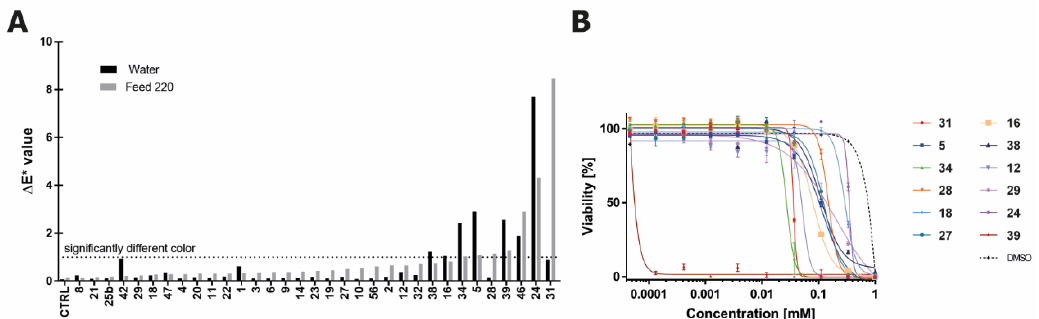
Figure 6. ( A ) Color change as measured by ∆ E* in both water and feed upon addition of degradation products. Solutions of degradation products in DMSO were spiked into aqueous solutions to yield a theoretical concentration of 500 µ M (1% DMSO). ( B ) Toxicity data for the Trp degradation products that produced a significant toxicity in CHOK1 GS cells as compared to the DMSO control. Error bars, S.D.